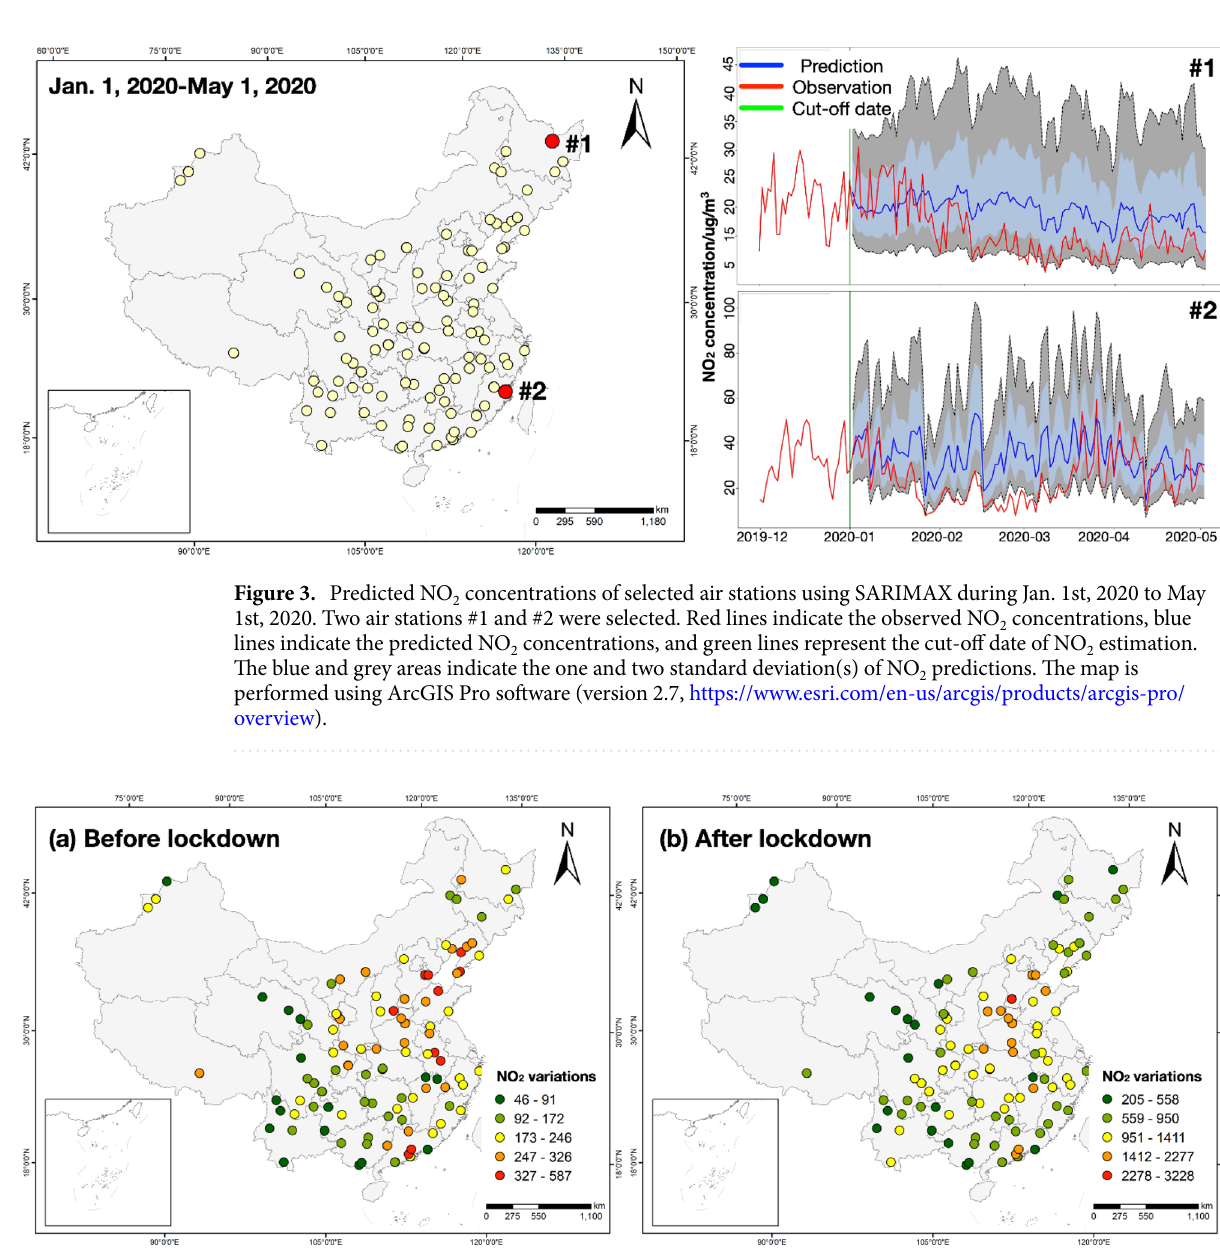
Figure 4. Time-series NO 2 variations between observed and predicted NO 2 of 145 air stations before and during lockdown calculated using DTW. ( a ) NO 2 variations before lockdown; ( b ) NO 2 variations during lockdown. High values of NO 2 variations represent greater changes among observed and predicted NO 2 . The maps are performed using ArcGIS Pro software (version 2.7, https:// www. esri. com/ en- us/ arcgis/ produ cts/ arcgis- pro/ overv